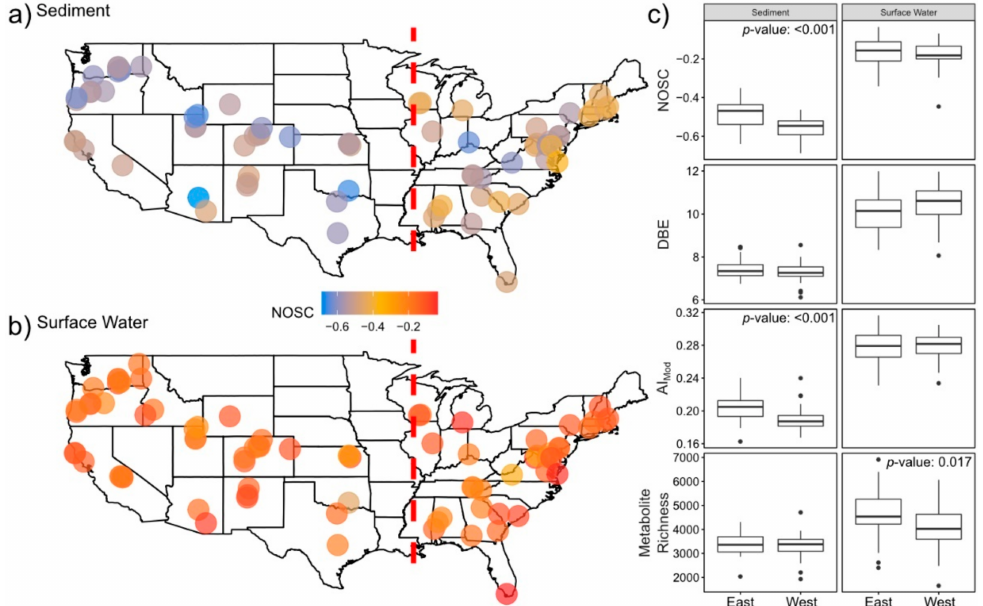
Figure 5. Maps of the United States revealing the spatial variability of average NOSC in sediment ( a ) and surface water ( b ) metabolomes. East vs. West spatial patterns for various derived metrics are displayed in panel ( c ). Statistically significant di ff erences identified via a two-sided Mann-Whitney U test are indicated by p -values listed in each comparison. The red dashed line represents the longitude of the Mississippi River at St. Louis, MO, USA—the dividing line between East and West samples.